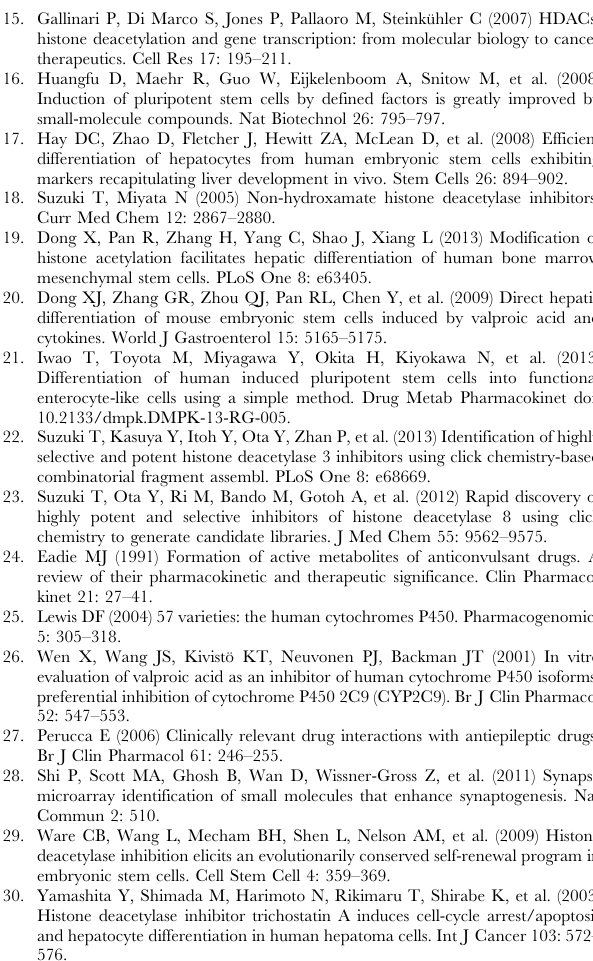
Figure S1 Effects of VPA on FLT4 expression. Fms-related tyrosine kinase 4 (FLT4) is known to lymphatic endothelial marker. Human induced pluripotent stem cells (Windy) were differentiated into hepatocytes. Valproic acid (VPA) was added to the medium for 72 h from day 18 (72 h), 168 h from day 12 (168 h), or 312 h from day 12 (312 h) at a final concentration of 2 mM. Each bar represents the mean 6 standard deviation (n =3). The graph represents gene expression relative to that in VPA-untreated hepatocyte-like cells [control (Ctrl)].